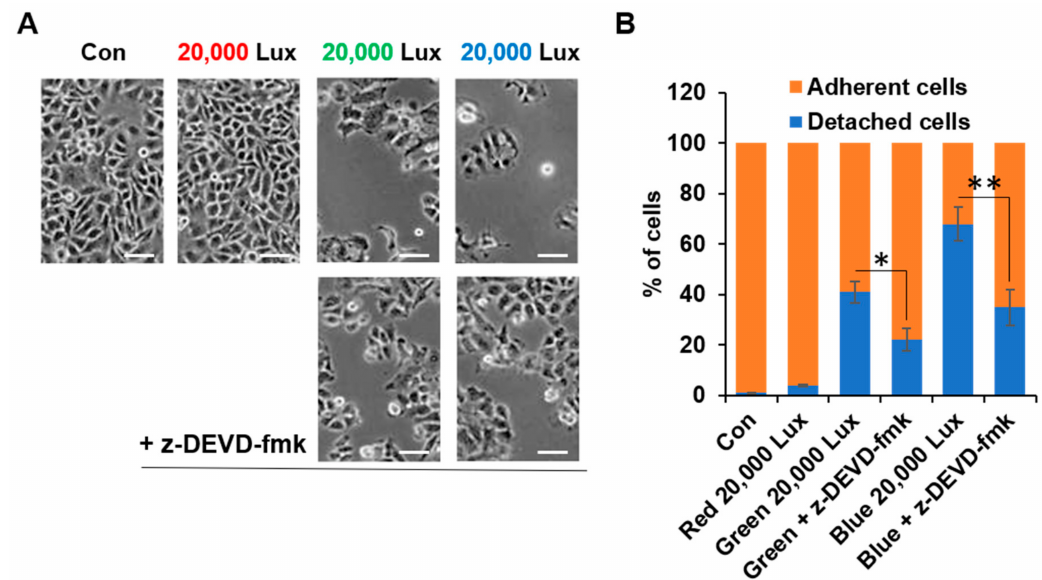
Figure 6. Green and blue LED light exposure increased cell detachment. HaCaT cells in a 6-well plate were exposed to the indicated LED lights for 1 h and then treated with or without z-DEVD-fmk (200 µ M) for 24 h ( A , B ). Representative phase-contrast images are shown ( A ) and percentage of cell adhesion and detachment relative to control ( B ) was quantified ( n = 3, ± SD). Scale bar, 100 µ m. * p < 0.01 and ** p < 0.001 vs.